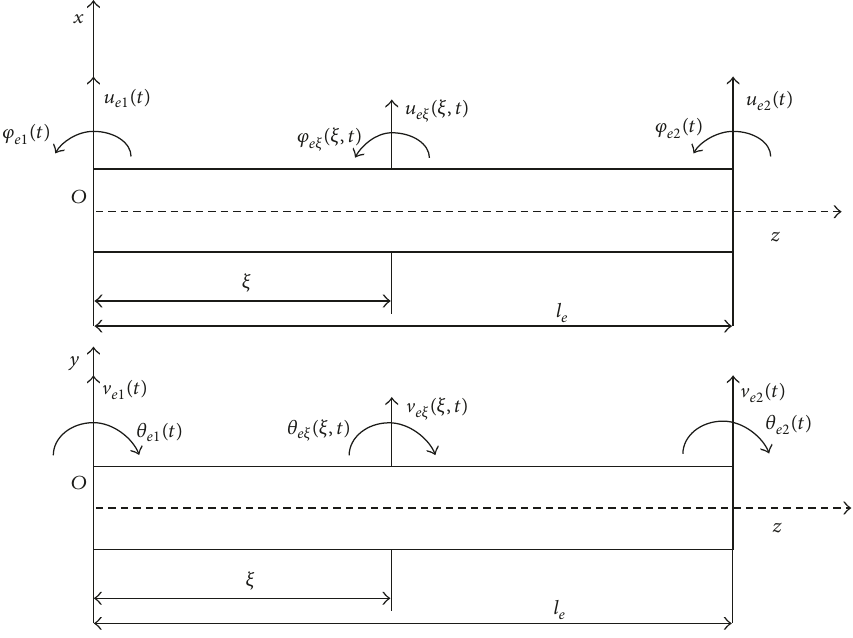
Figure 1: Diagram of beam